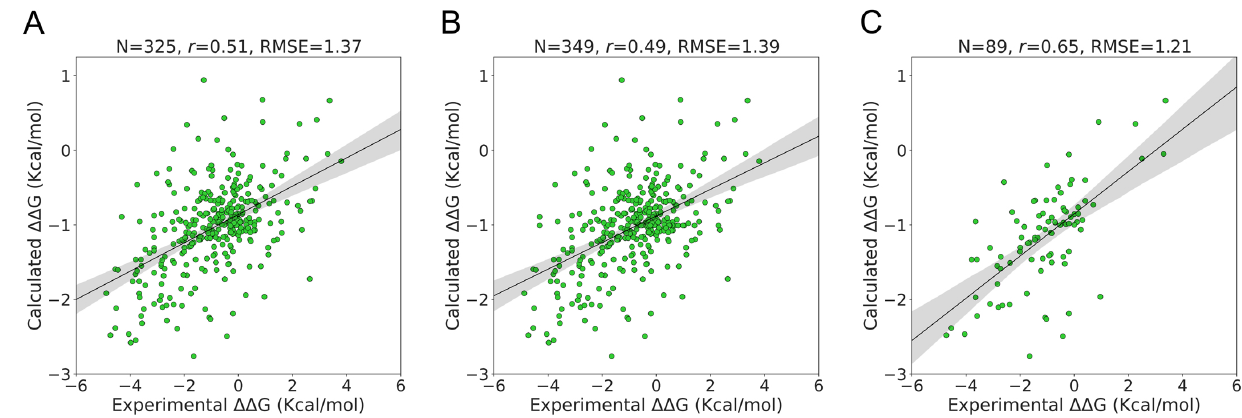
Figure 3. Performance on S350 dataset. Agreement between the experimental ∆∆ G and the PSP- GNM-calculated ∆∆ G is shown for ( A ) 325 mutants with a PSP-GNM-calculated ∆∆ G, ( B ) all 349 mu- tants, ( C ) 89 mutants with experimental temperatures ranging from 24 ◦ C to 26 ◦ C and pH ranging from 6.8–7.2. The regression line with the 95% confidence interval (shaded gray) is shown for all three cases. The optimal agreement is seen for ( C ), with a Pearson correlation of 0.65 and an RMSE of 1.21